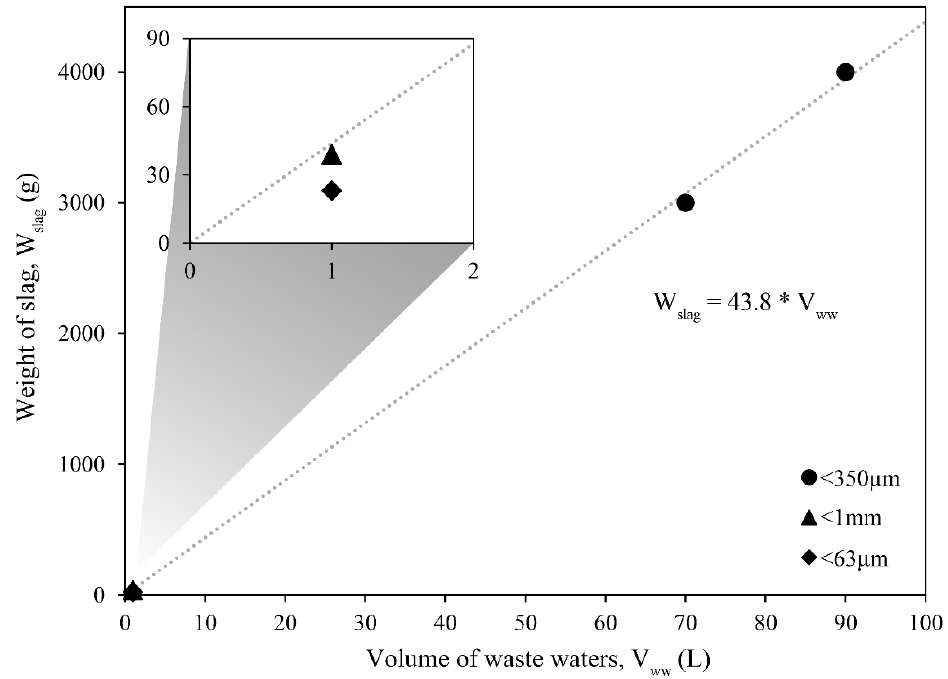
Figure 6. Linear regression of the 90 L and 70 L trials. Precedent trials have been added for comparison [9,10].